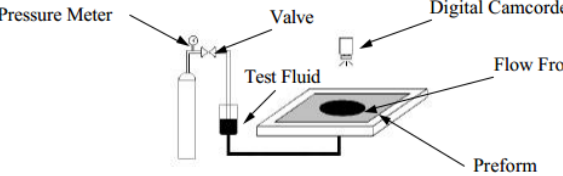
Figure 4: Schematic diagram of 2D radial flow experiment [15]